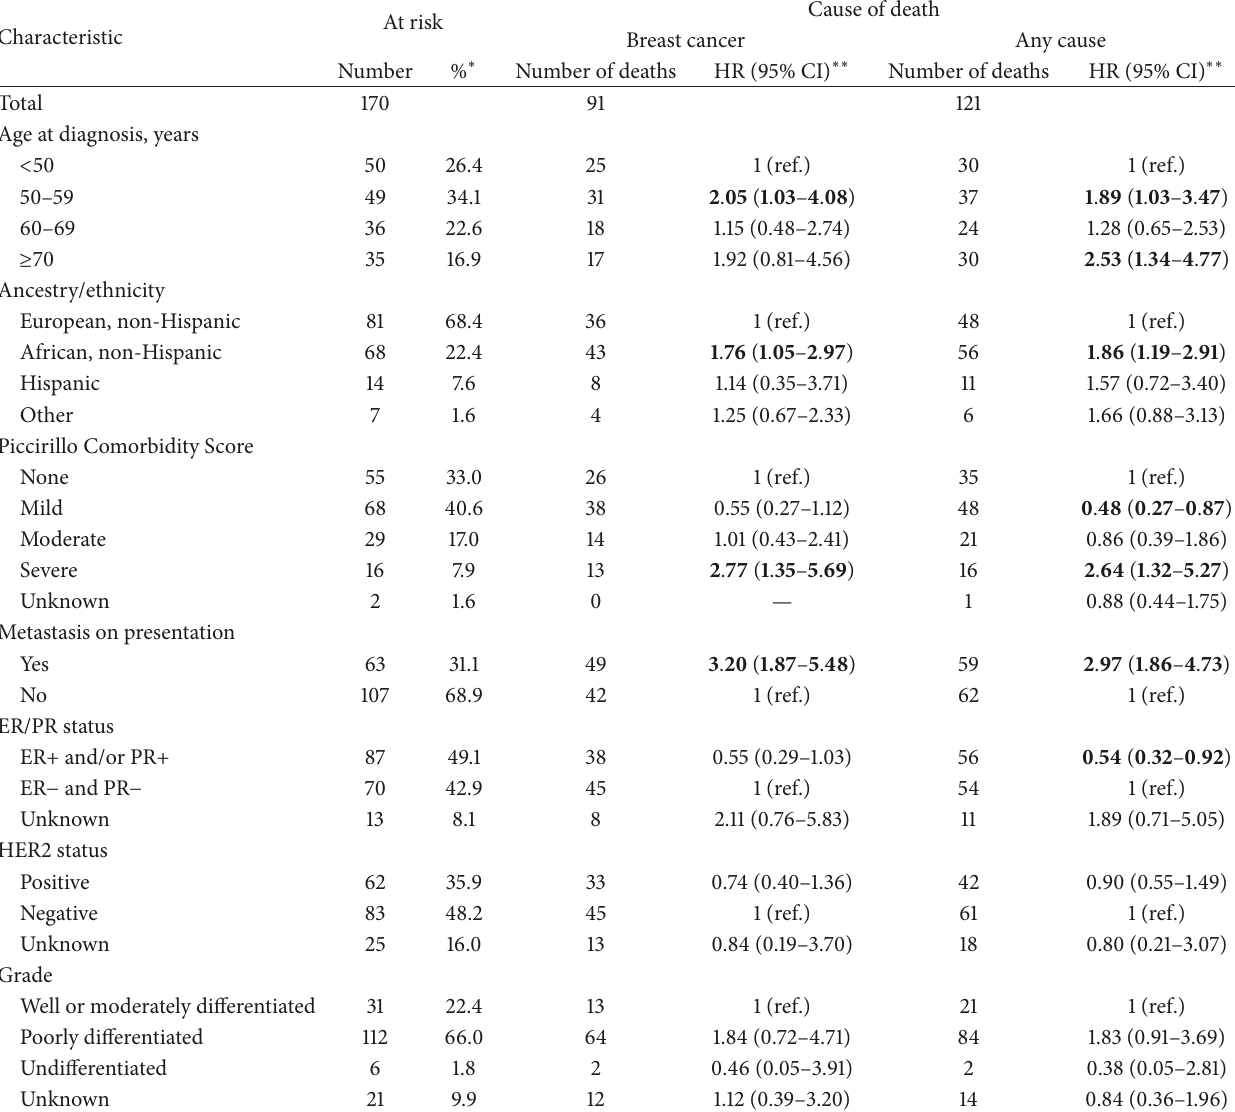
Table 3: Hazard ratios for inflammatory breast cancer patient mortality based on patient characteristics, Patterns of Care Study, 2004–2012.